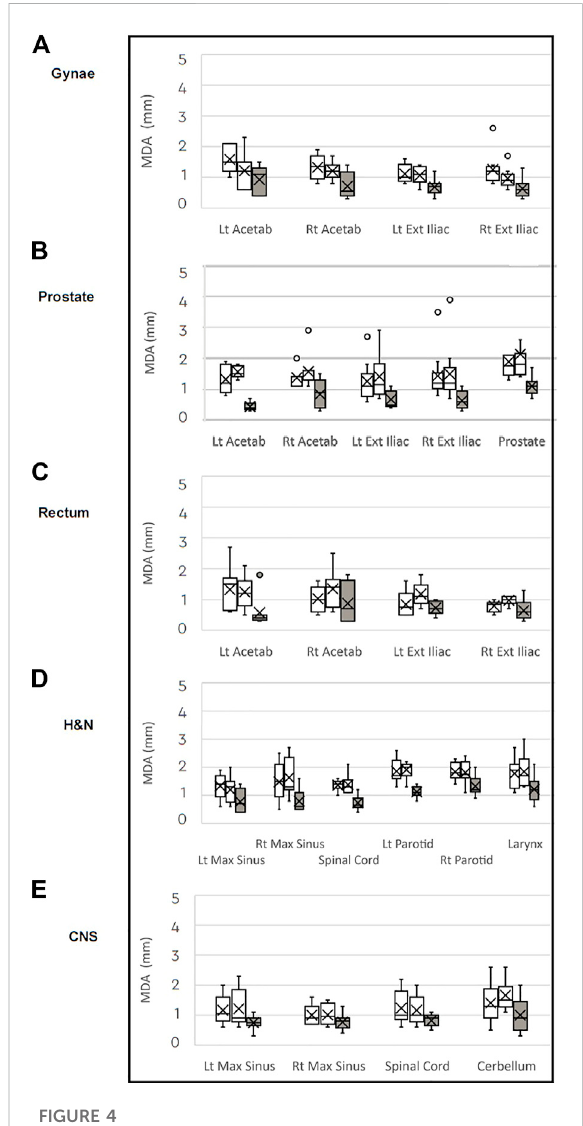
FIGURE 4 Box plots of median Mean Distance to Agreement (MDA) in millimeters for each anatomical structure comparing the CT to MRI datasets (white) and MRI to MRI (grey) for the (A) gynaecological; (B) prostate; (C) rectal: (D) H&N: and (E) CNS patient